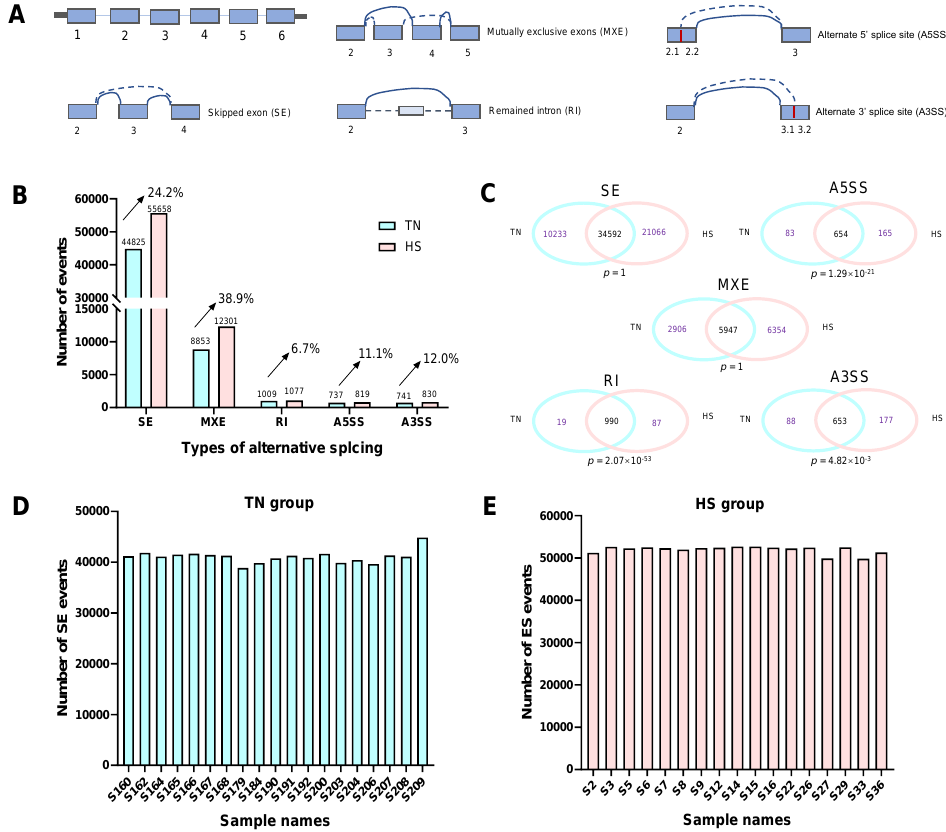
Figure 2. Alternative splicing (AS) events were identified at the group level and the sample levels. ( A ) Five determined AS types: skipped exon (SE), mutually exclusive exons (MXE), remained intron (RI), alternate 5 (cid:48) splice site (A5SS), and alternate 3 (cid:48) splice site (A3SS). ( B ) Total number of AS events categorized based on AS types in thermal neutrality (TN) and heat stress (HS) conditions. ( C ) Comparisons of the five AS types between the TN and HS groups. ( D ) Number of SE events at the sample level for the TN group. ( E ) Number of SE events at the sample level for the HS